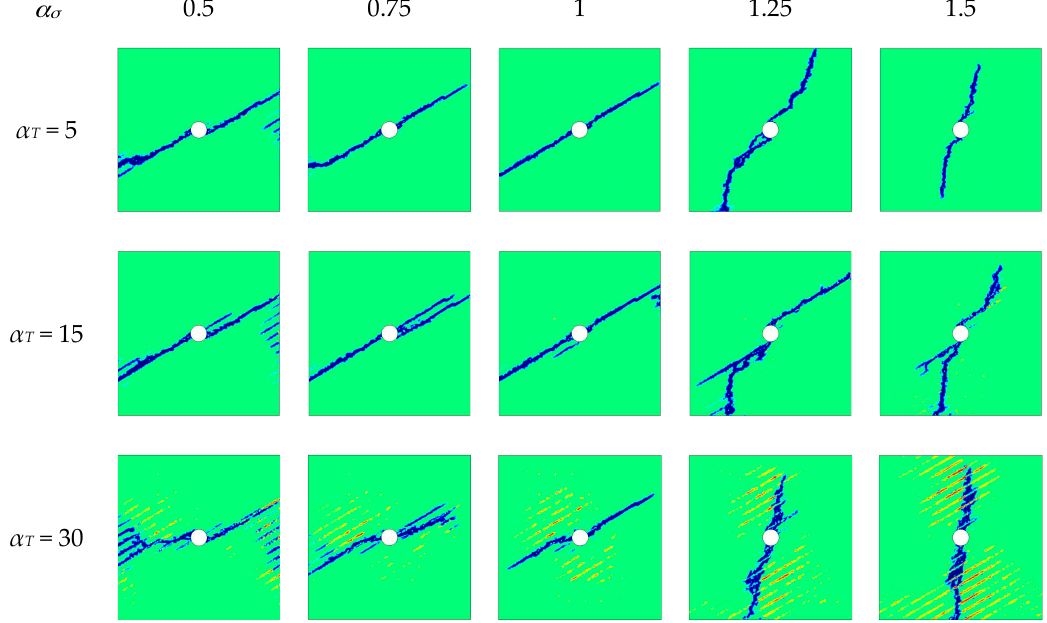
Figure 20. Evolution of fracture network with stress ratio and strength ratio during nitrogen